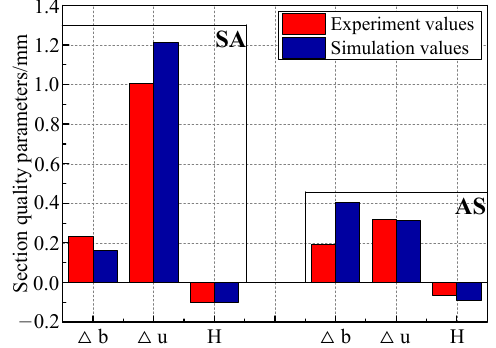
Figure 5. Section profile comparison. ( a ) Experiment section and simulation section of the SA joint; ( b ) experiment section and simulation section of the AS joint; ( c ) original profile and deformed profiles of rivets.